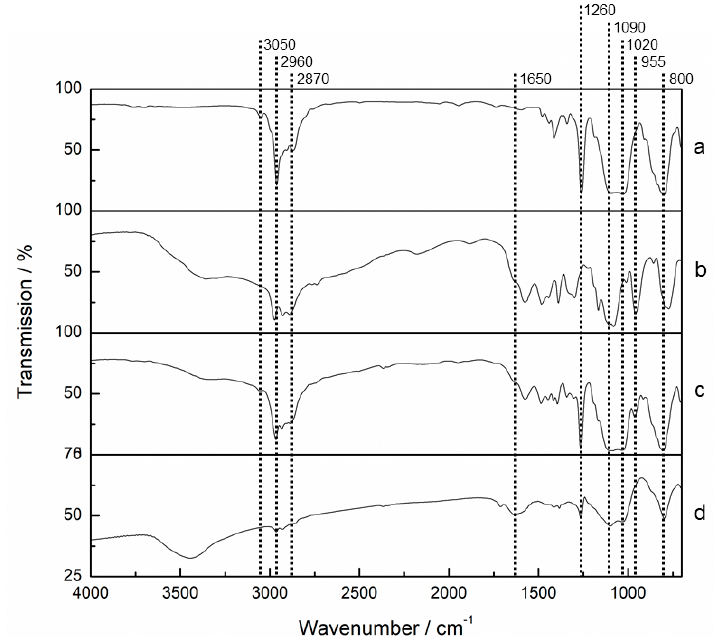
Figure 2. FTIR transmittance spectra of AES(800)-1 / 2. ( a ) PDMS(800)-GET; ( b ) 3-APTES; ( c ) AES(800)-1 / 2 during synthesis; ( d ) AES(800)-1 / 2 final hybrid (presented with a different scale, for higher definition purposes).